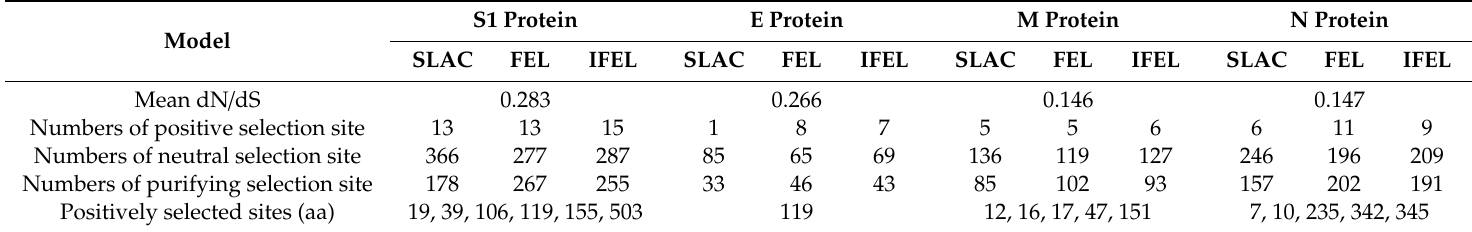
Table 3. Selection profile of S1, E, M, and N proteins of Guangxi IBV isolates.